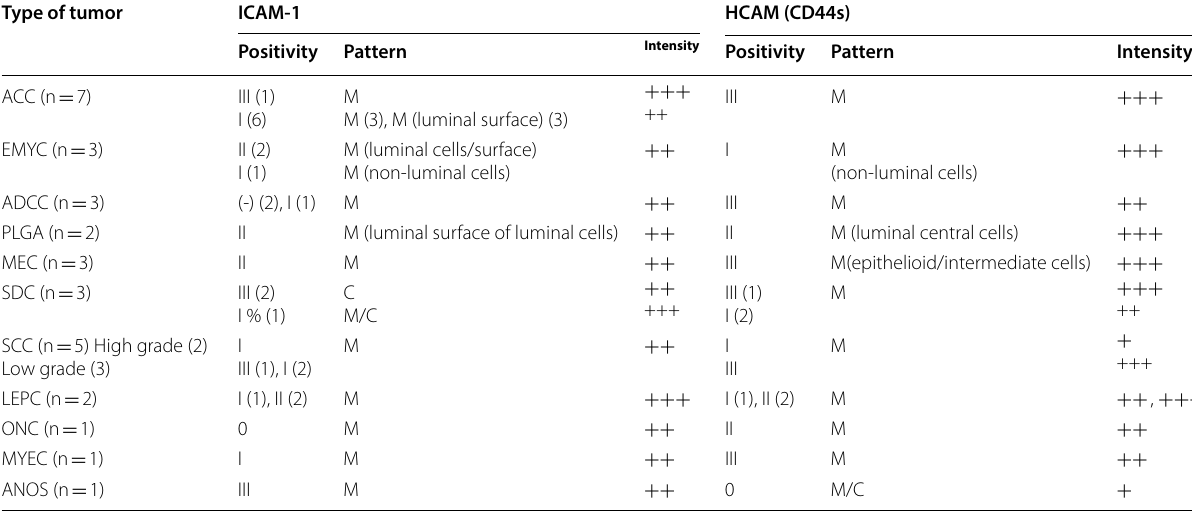
Table 3 Expression of cell adhesion molecules ICAM-1 and HCAM (CD44s) in malignant